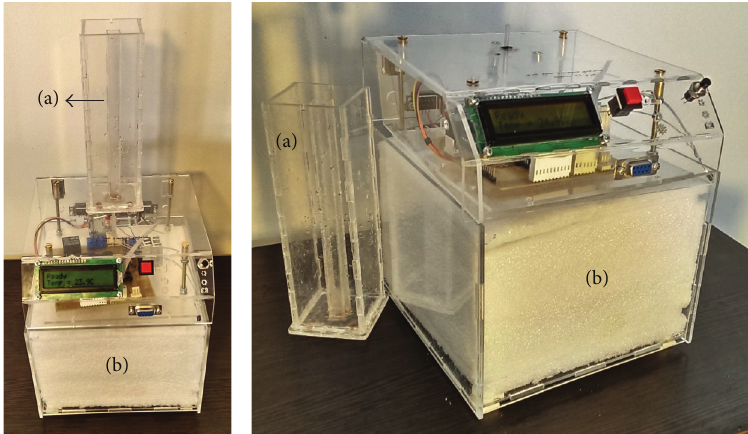
Figure 1: Automated urine collection device. (a) Disposable container. (b) Main body.